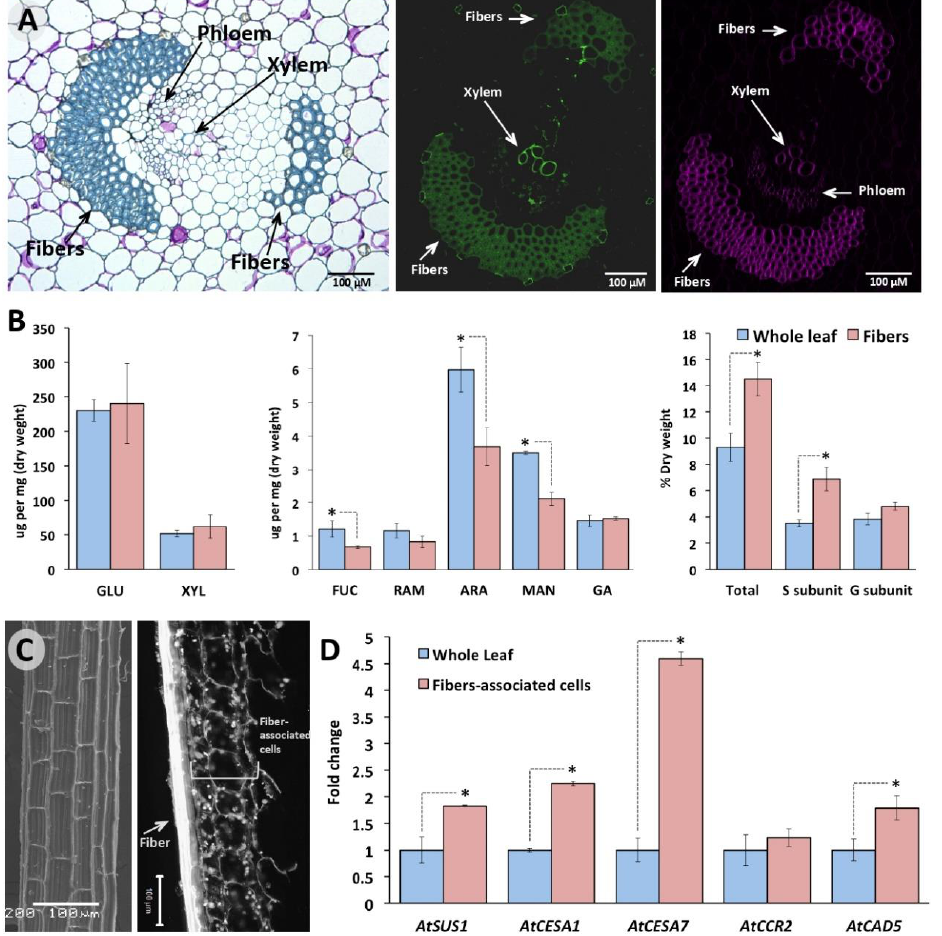
Figure 7. Key genes for cellulose and lignin have a high expression in cells surrounding fibers of A. tequilana leaves. ( A ) Sclerenchyma fibers surrounding vascular bundles. Heavily thickened secondary cells forming fiber caps walls were visualized in cross leaf sections after Toluidine Blue O (TBO) staining (left); lignification of fibers and xylem cells were visualized by lignin autofluorescence imaged by confocal laser scanning microscopy (LCSM) (middle). Cellulose was detected by Direct Red 23 staining and visualized by LCSM (right). ( B ) Monosaccharides analysis (left and middle) by high- performance anion exchange chromatography with pulsed amperometric detection (HPAEC-PAD) and lignin quantification (left) by pyrolysis gas chromatography/mass spectrometry (py-MBMS) of sclerenchyma fibers and cell walls of whole leaf. FUC: Fuccose, RAM: ramose, ARA: arabinose, MAN: mannose, GA: galacturonic acid, GLU: glucose; XYL: xylose. ( C ) Scanning Electronic Microscopy (SEM) of fiber (left) and fibers-associated cells stained with propidium iodide and imaged by LSCM (right). ( D ) Expression levels of key genes for cellulose and lignin biosynthesis quantified by qPCR assays. Total RNAs isolated from whole leaf and fibers-associated cells were used for RT-qPCR assays (right). Glycerol-3-Phosphate Dehydrogenase (GPDH) was used as a load gene. Values are means ± SD. Asterisks indicate significant statistical differences between fibers/fibers-associated cells and whole leaf determined by Tukey’s HSD test ( p ≤ 0.05).